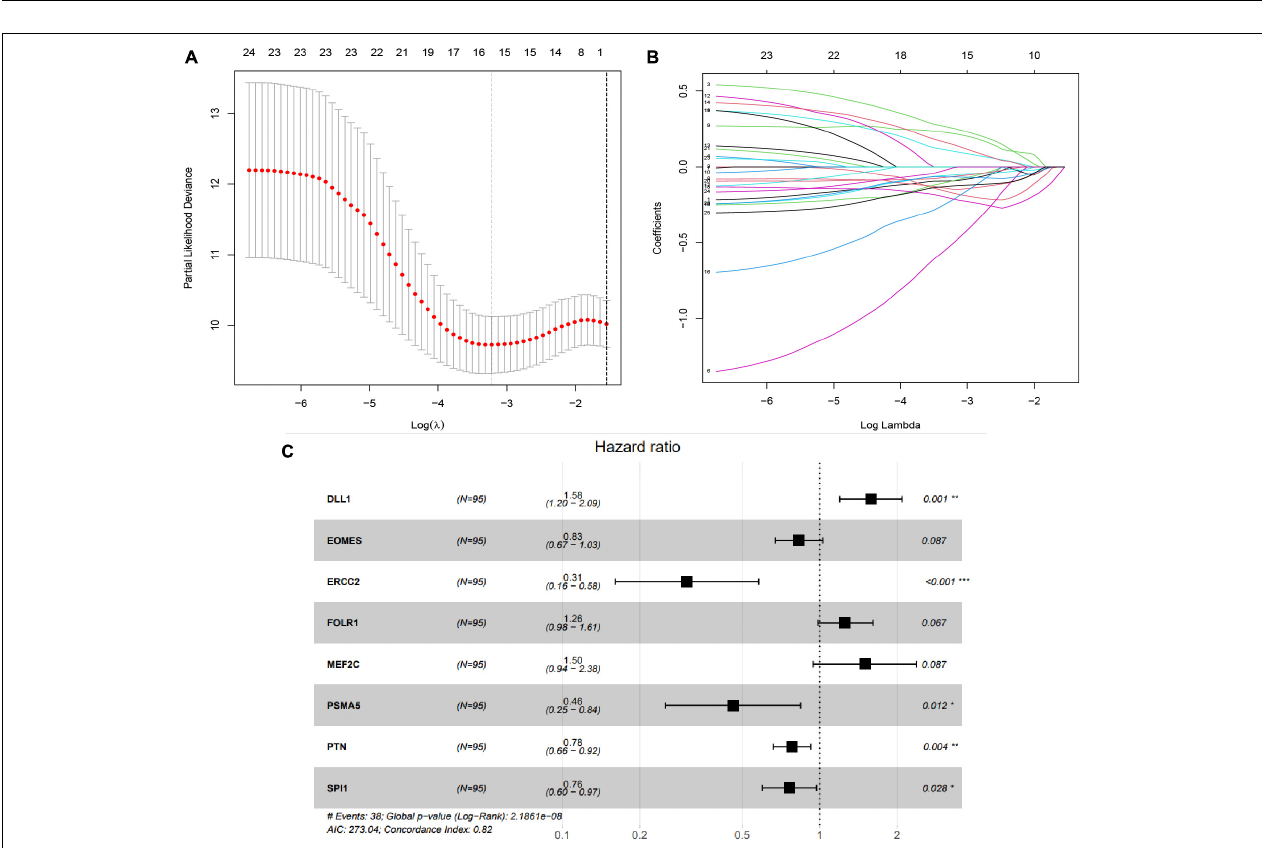
FIGURE 3 | Establishment of stem cell-related gene prognostic signature. (A,B) The LASSO Cox analysis determined 15 prognostic genes. (C) The forest map of multivariate Cox analysis. * P < 0.05; ** P < 0.01; *** P < 0.001.